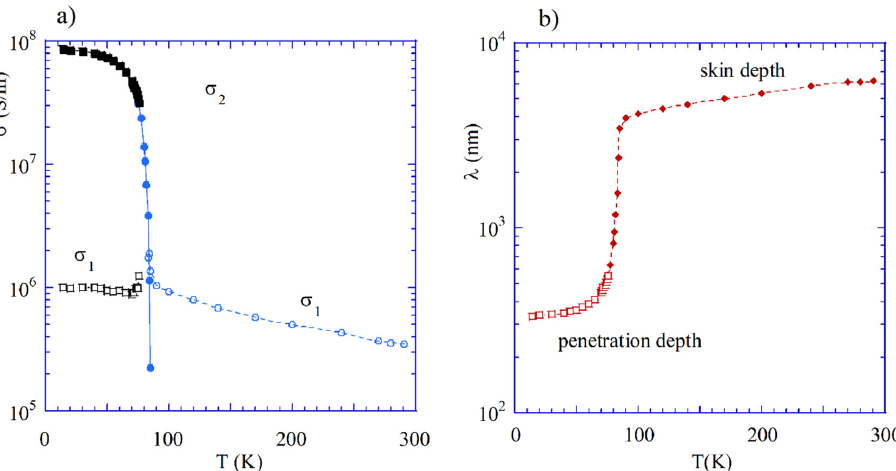
Figure 10. ( a ) Components of the complex conductivity of YBCO sample measured with sapphire rod resonator (at tem- peratures below 80 K) and single post dielectric resonator (above 80 K). ( b ) The effective penetration depth evolution of YBCO as a function of temperature, reflecting conductivity transition from the superconducting state to the normal state. © IEEE Publishing. Reproduced from [36] with permission. All rights reserved.